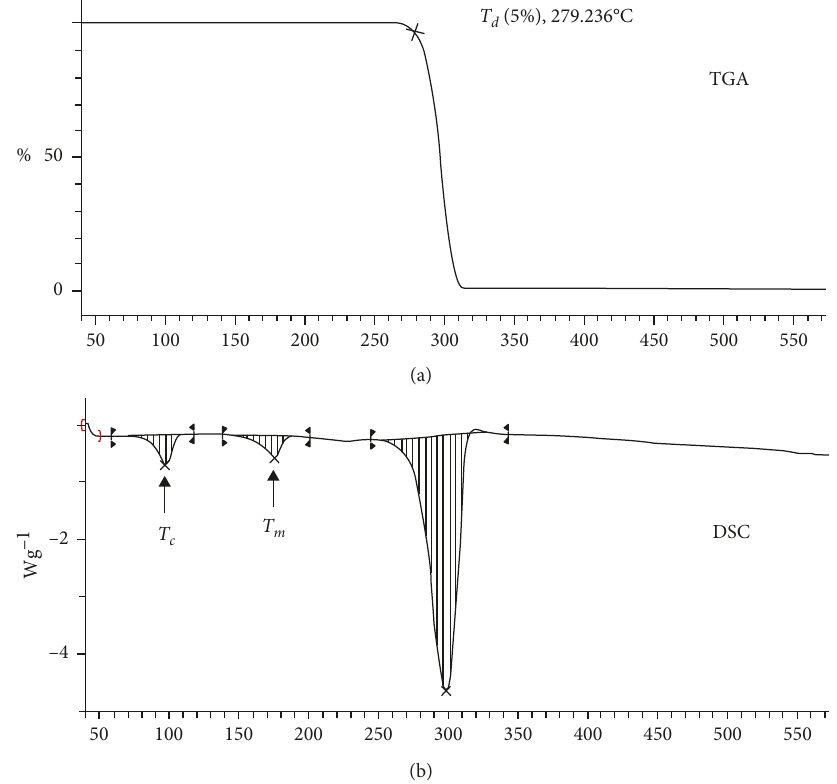
Figure 3: TGA and DSC thermographs of purified PHBV extracted material from R. rubrum (ATCC